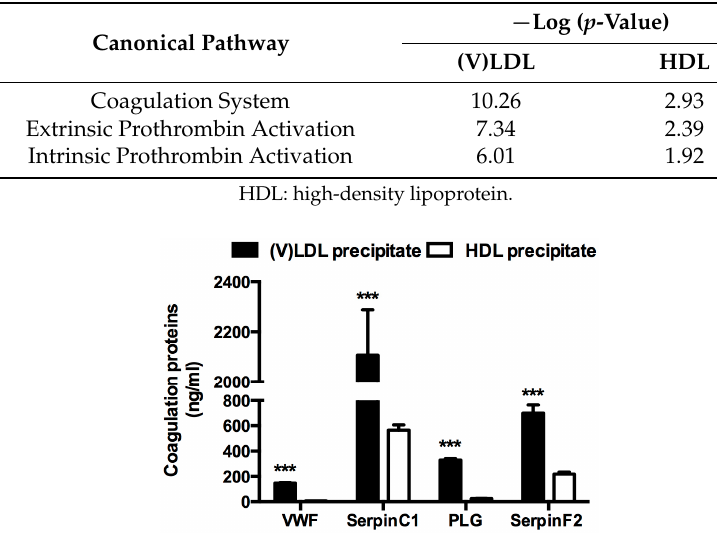
Table 1. Canonical Pathways over-represented in the very-low- and low-density lipoprotein ((V)LDL) precipitate.